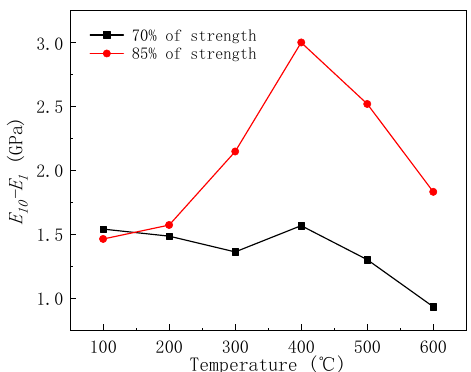
Figure 7. Difference in elastic modulus between the first loading ( E 1 ) and the tenth loading ( E 10 ) versus temperature.